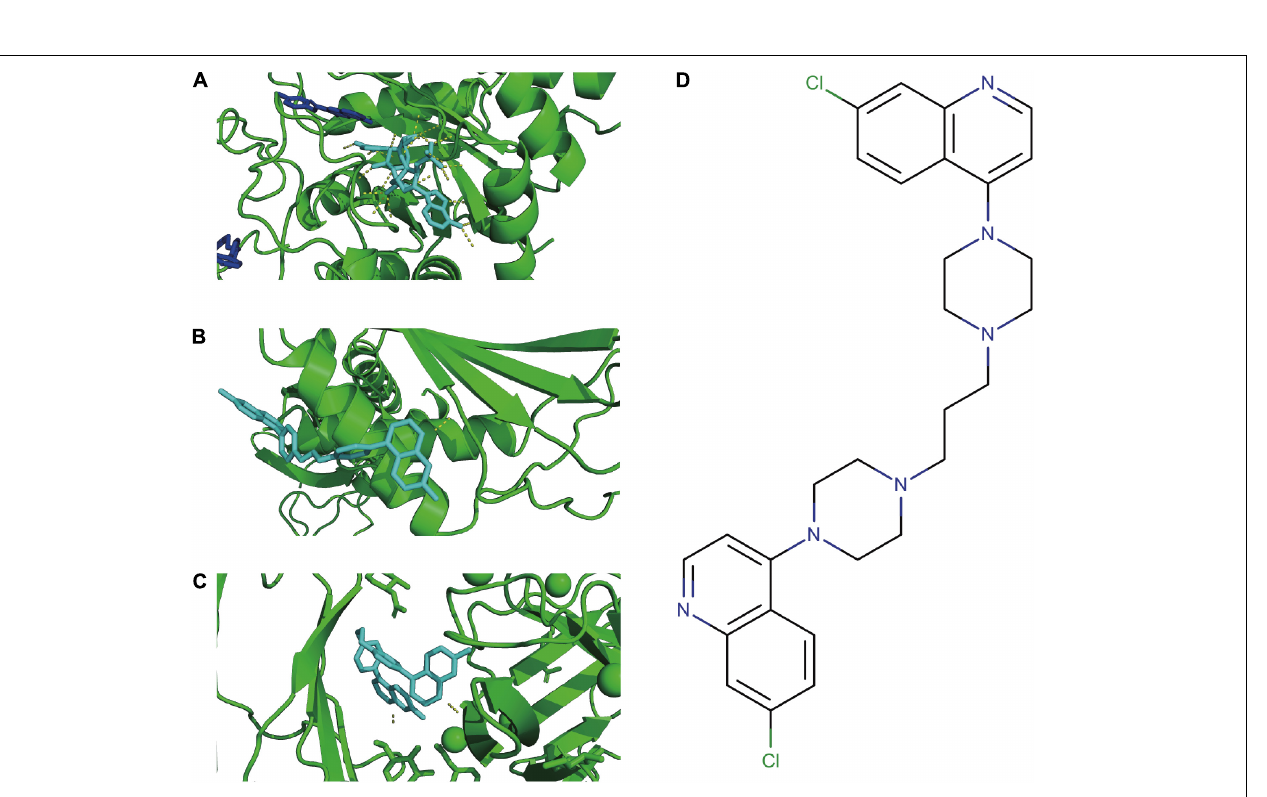
Frontiers in Psychiatry |